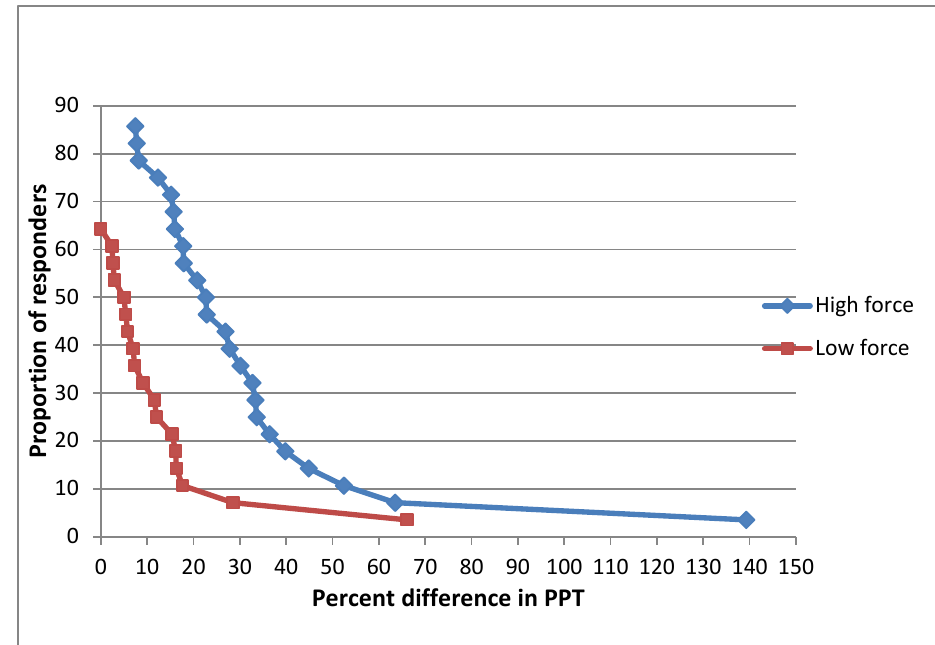
Figure 4. Cumulative proportion of responders analysis graph T6 after high and low mobilizations.